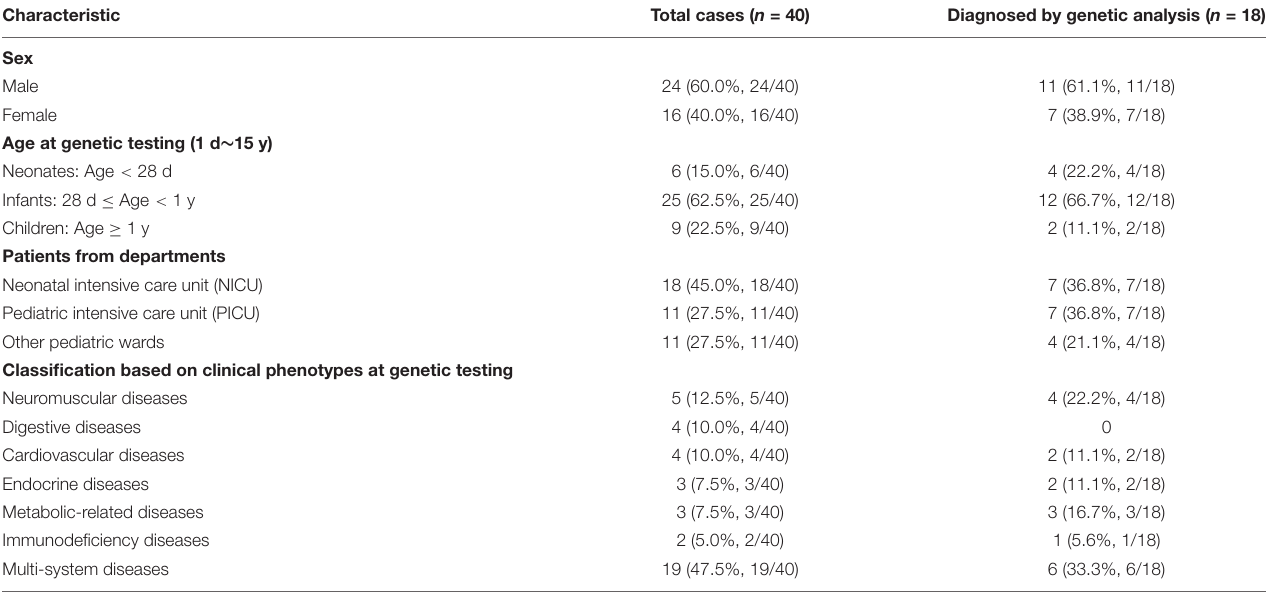
TABLE 1 | General description of the 40 pediatric patients with rapid genetic